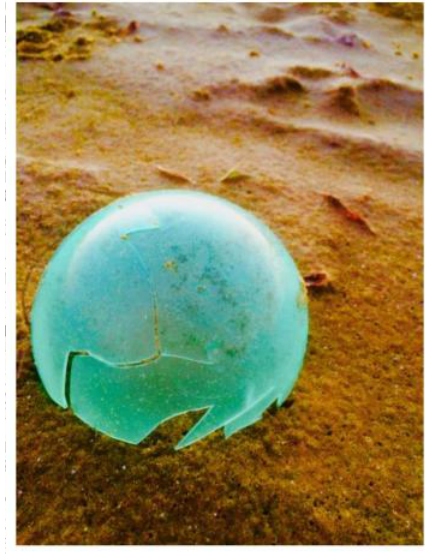
Figure 6. Plastic on Hoylake Beach.